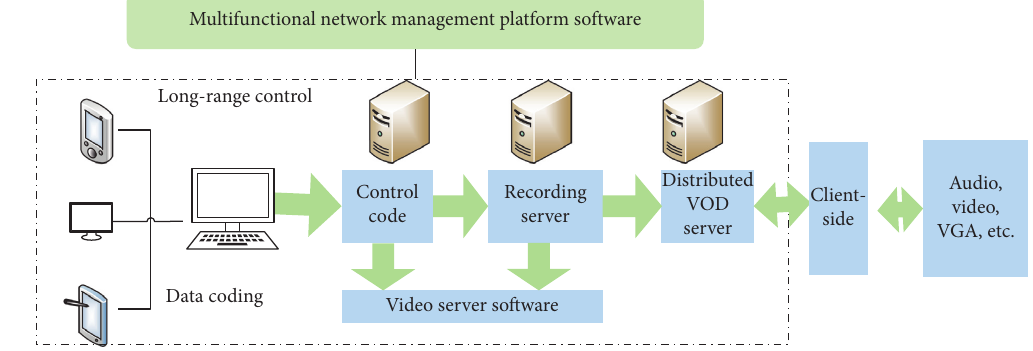
Figure 1: Basic framework of mobile teaching platform based on streaming media.